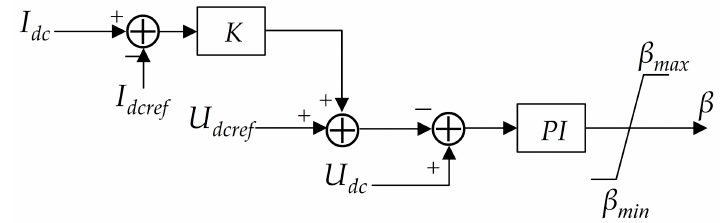
Figure 7. Traditional DC voltage droop controller.